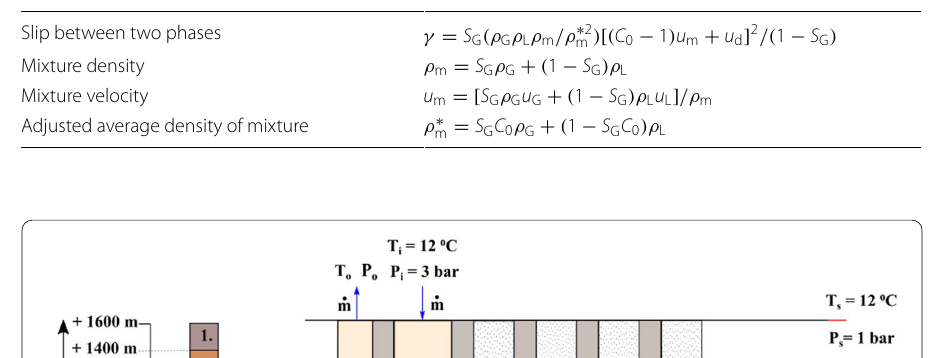
1599.50 m to 1580 m). Numbered + −